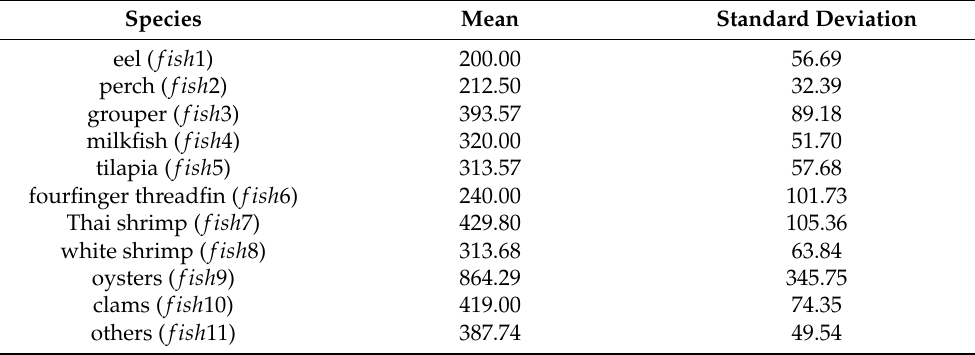
Table 4. The average value of WTP for different aquaculture species (NTD/month).